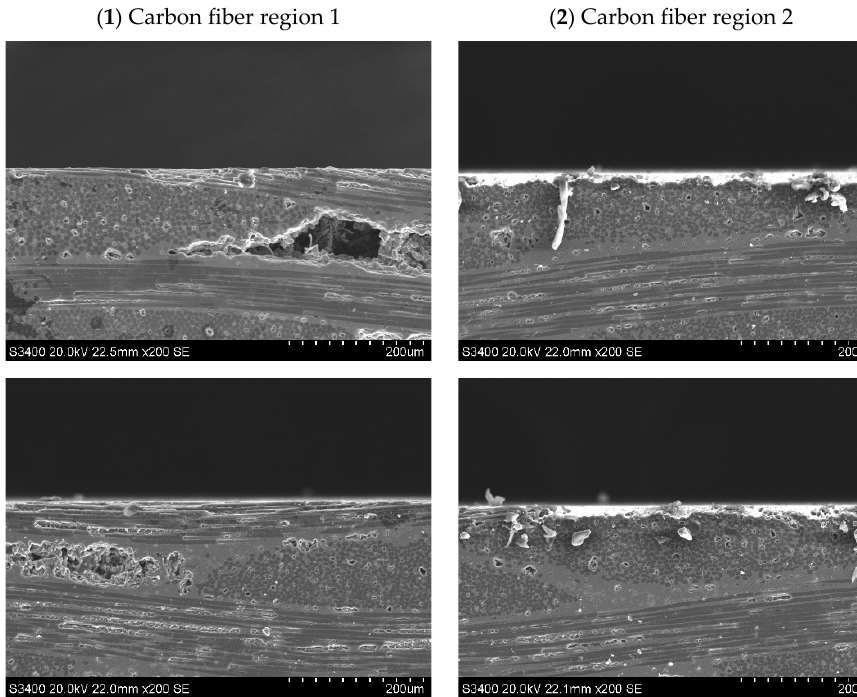
Figure 25. Subsurface morphologies of the C/SiC composite material after common grinding and ultrasonic vibration-assisted grinding(v s = 1.26 m/s, v w = 500 mm/min, a p = 0.1 mm).